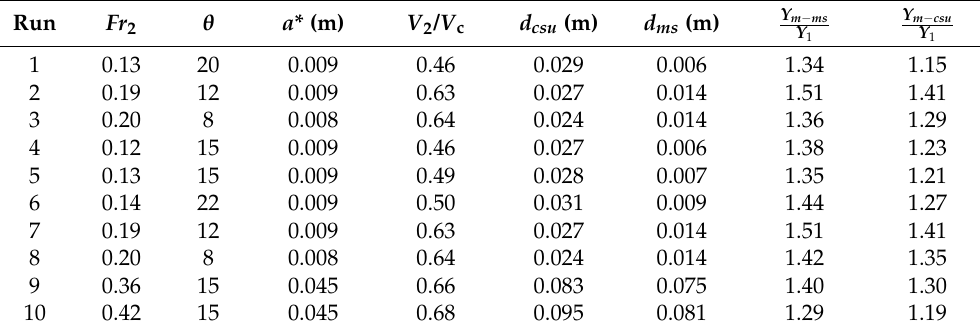
Figure 3. Schematic diagram for calculation of maximum scour depth. Table 2. Summary of experimental results to calculate maximum scour depth.